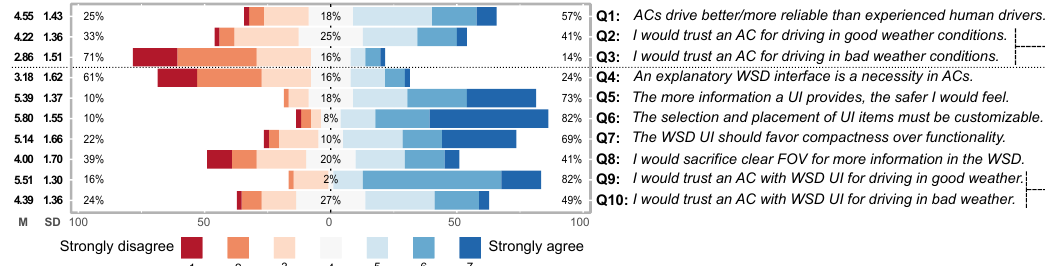
Figure 1. Selected questionnaire items in our human-centered design approach. After item Q3 , participants were introduced to the concept of an explanatory windshield display user interface. The dashed line marks related items that allow comparison before and after users knew the UI